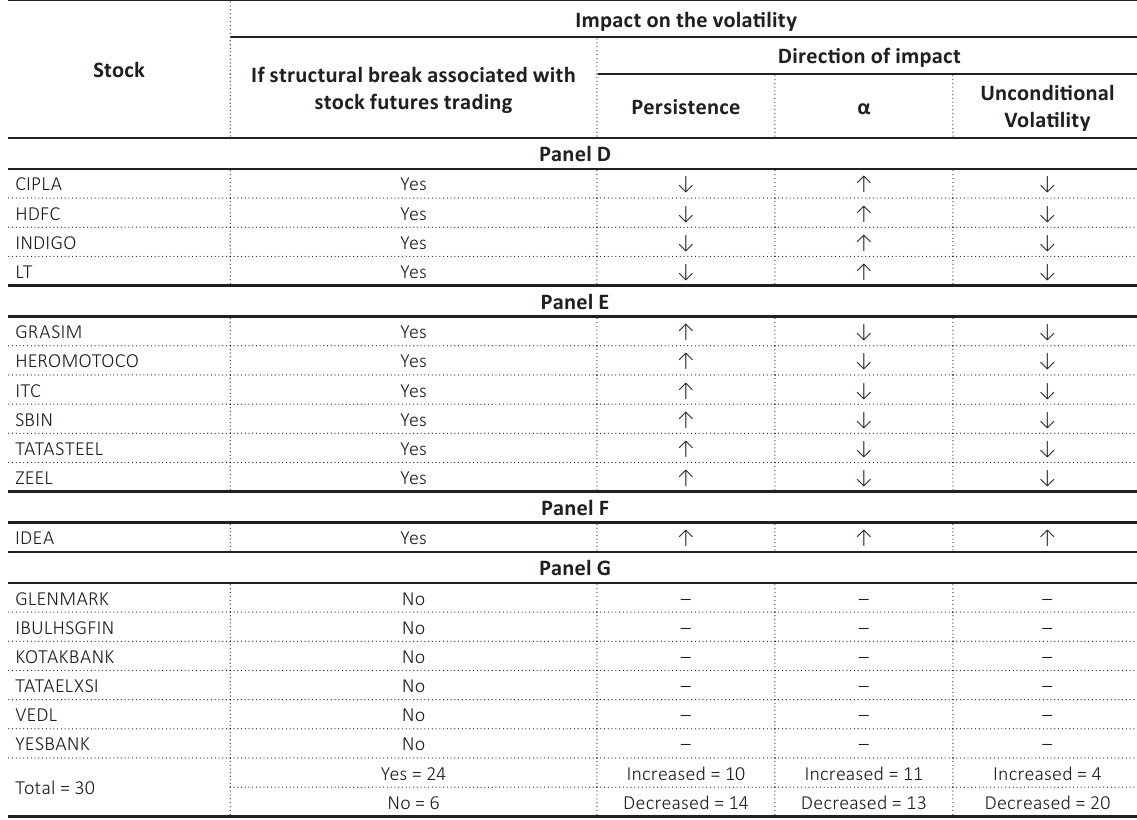
Table 4 (cont.). Impact of stock futures on the volatility of underlying